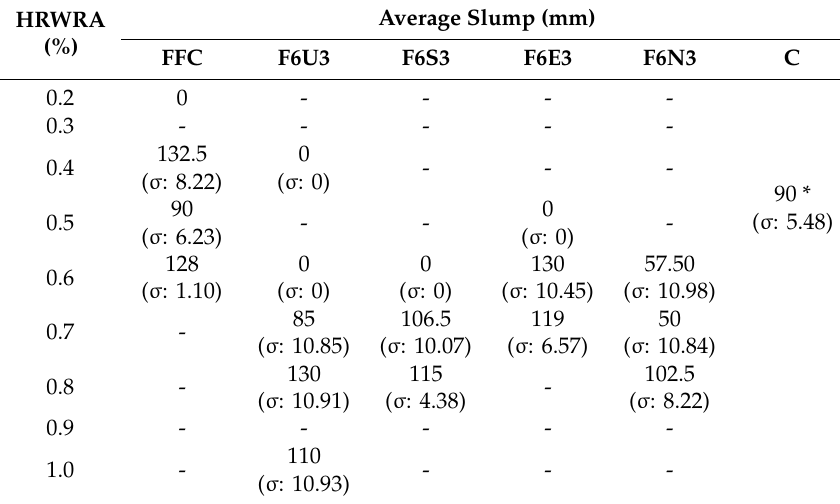
Table 4. Average slump for developed HyFRC ( σ = standard